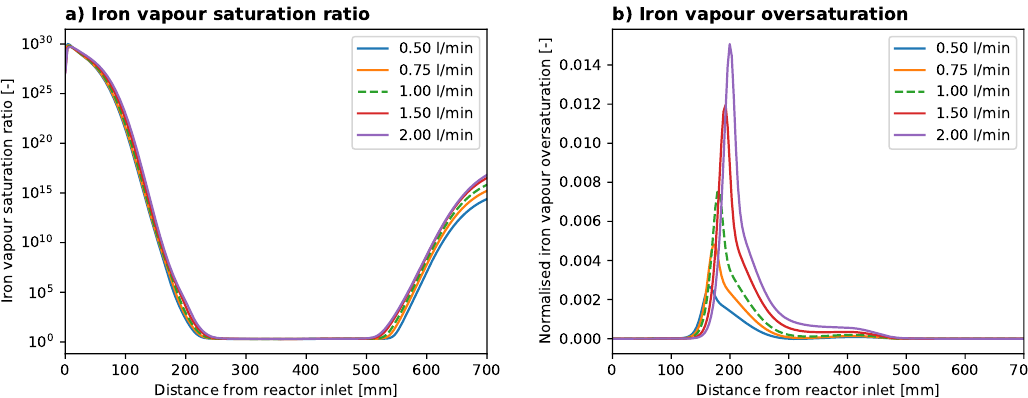
Figure 3. Plots of the ( a ) iron vapour saturation ratio S = g / g ∗ s and ( b ) iron vapour oversaturation ∆ g = g − g ∗ s , as a function of distance from the reactor inlet, for different flowrates. 0.00.20.40.60.81.0 Figure 4. Plots of ( a ) normalised particle mass fraction and ( b ) normalised particle number density, for different inlet flowrates, at a peak temperature of 1250 ◦ C and a ferrocene mass fraction of 0.5mass%. Nucleation starts at about 200mm from the inlet, and the main evaporation zone is between 300 and 400